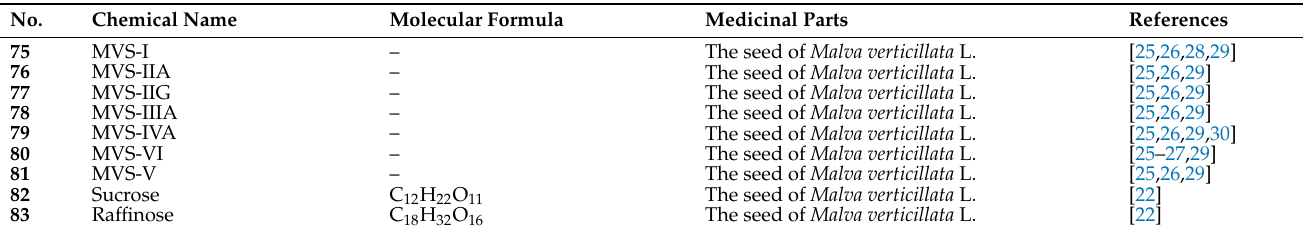
Table 6. The polysaccharides identified from Fructus Malvae .